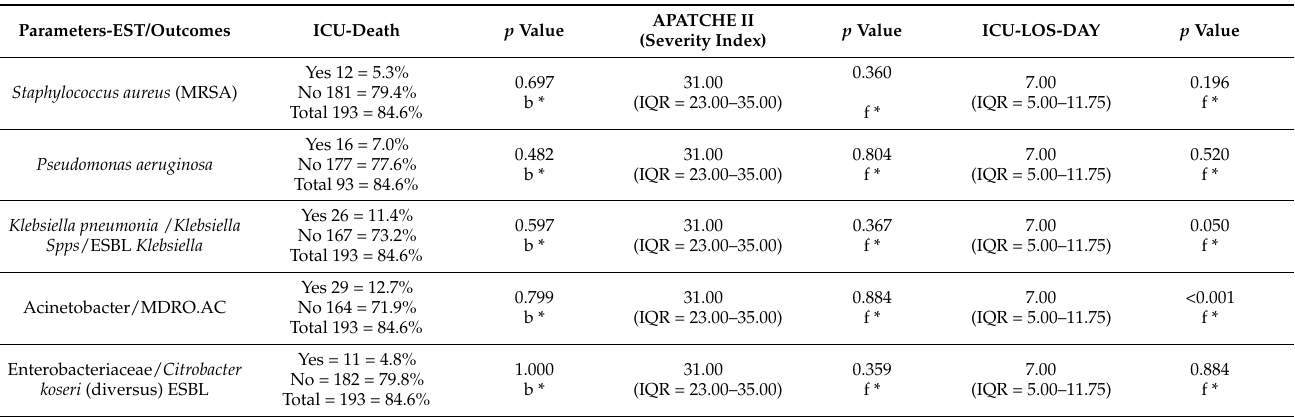
Table 4. Association of isolated MDRO organisms with their outcomes (mortality, APACHE II score, ICU-LOS).